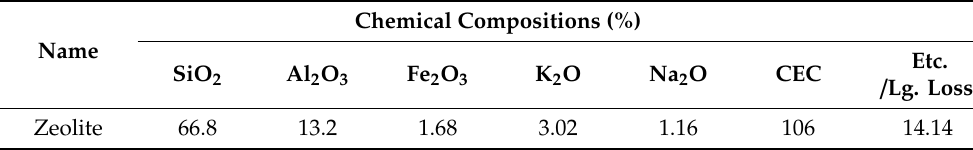
Table 2. Chemical compositions of natural zeolite.